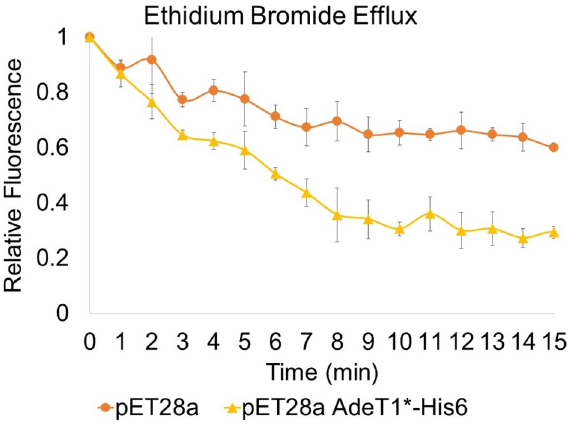
Figure 7. Efflux of ethidium bromide from E. coli BL21(DE3) cells expressing pET28a or pET28a AdeT1*- His6. Each datapoint represents an average of three technical replicates, standard deviation is annotated for each average. The data shown is a representative example among four biological replicates. Results of the other biological replicates are shown in Supplementary Fig. S11.